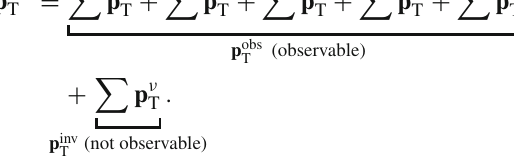
= p Z as shown in T T . T